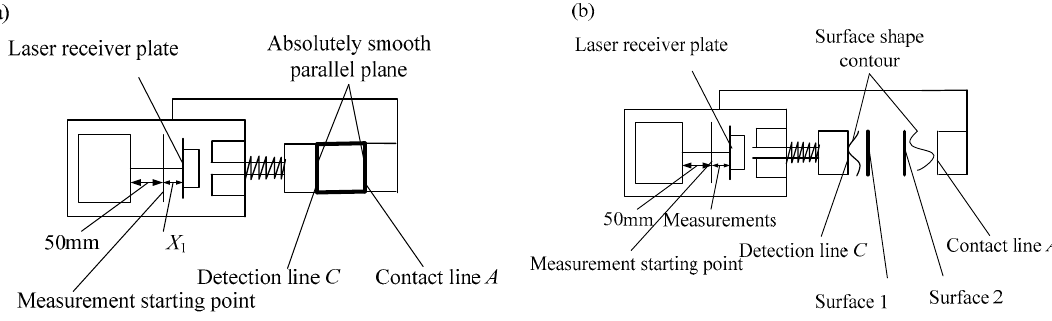
Figure 6. The positional relation between contact line A and detection line C : ( a ) The distance between the contact line A and the detection line C is unchanged ( b ) Contact line A and detection line C are located in two surfaces with shape contours.